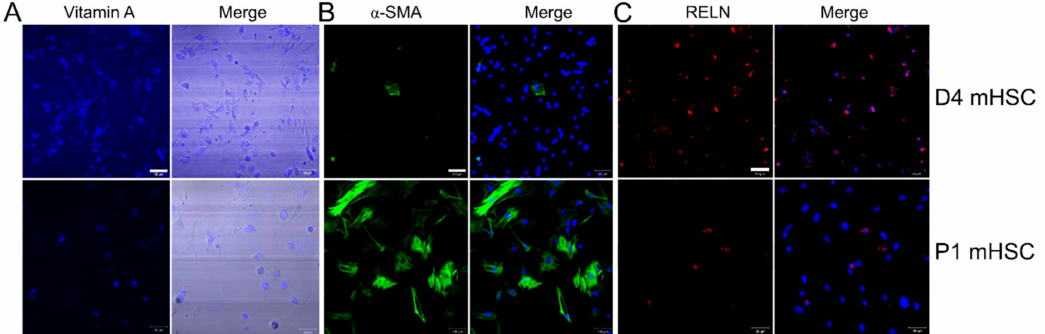
Figure 1. Characterization of primary mouse HSC. ( A ) Primary D4 or P1 mHSC were evaluated for vitamin A autofluorescence (left) or examined by phase contrast (right), and imaged by confocal microscopy. Based on six fields, Vitamin A was positive in 91.3 ± 3.4% of D4 mHSC and 85.4 ± 8.0% of P1 mHSC. ( B ) D4 or P1 mHSC were stained with anti- α SMA (left) which was then merged with DAPI (right). Based on three fields, α SMA was positive in 3.3 ± 0.7% of D4 mHSC and 93.3 ± 5.0% of P1 mHSC. ( C ) D4 or P1 mHSC were stained with anti-reelin (left) which was then merged with DAP1 (right). Based on two fields, the frequency of reelin-positive cells was 98.4 ± 1.6% for D4 mHSC and 13.1 ± 1.2% for P1 mHSC. Bars: 50 µ m for A and C; 100 µ m for